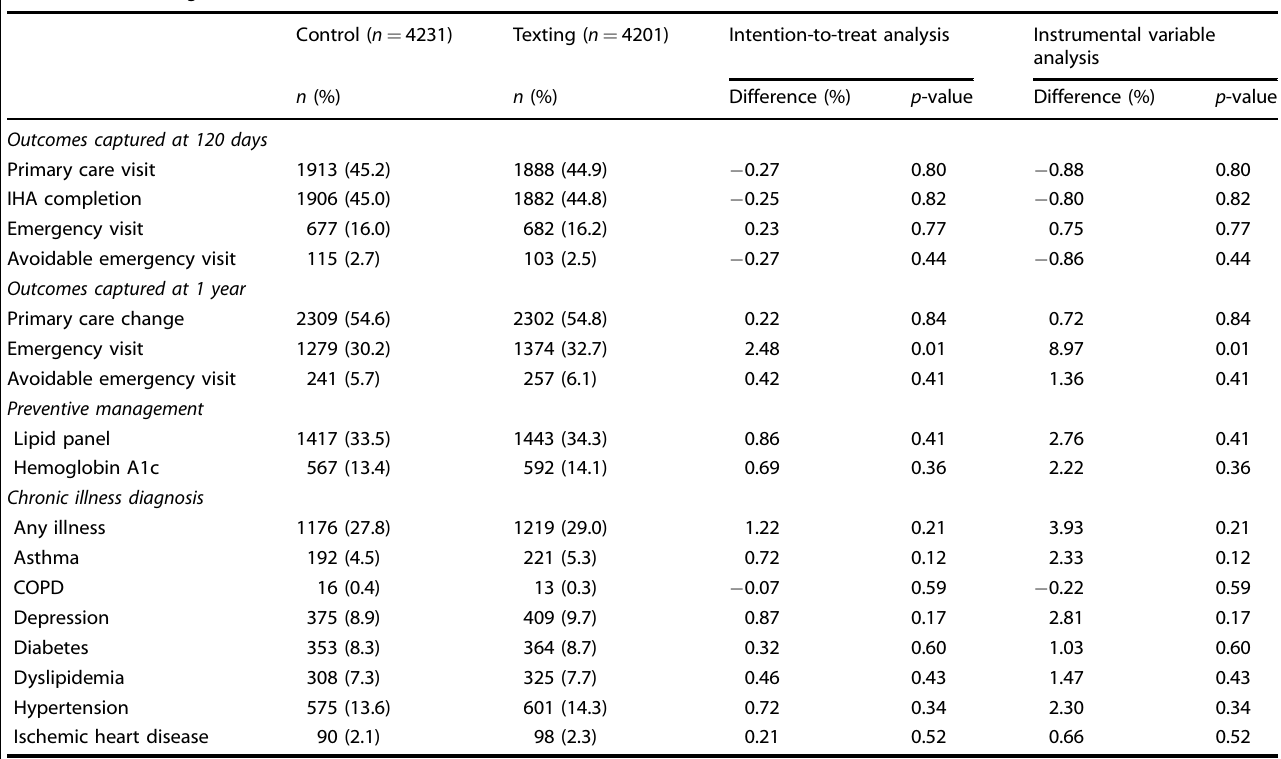
Table 2. Text message outcomes. Control ( n = 4231) Texting ( n = 4201) Intention-to-treat analysis Instrumental variable